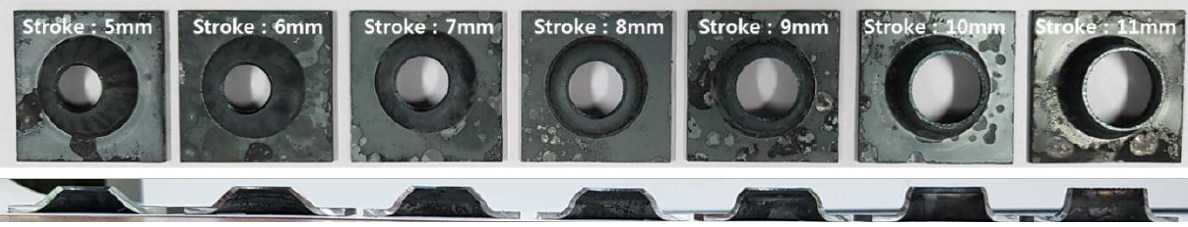
Figure 8. Extruded collar shape according to stroke.